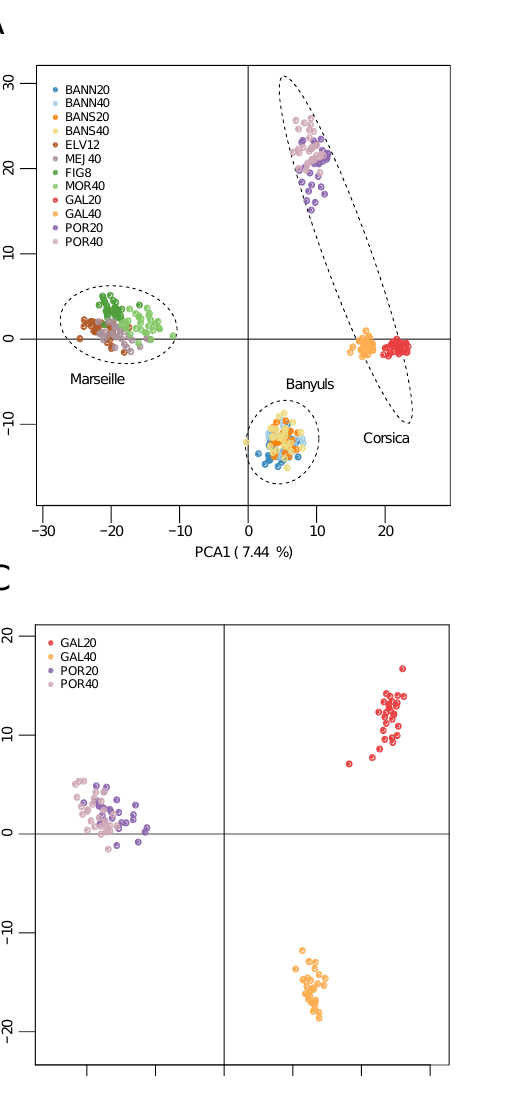
Figure 1. Principal component analysis (Axes 1 and 2) of A) the 12 red coral populations (n = 354 individuals, 27 461 SNPs), B) the four red coral populations from Marseille (n =119 individuals, 27 461 SNPs), C) the four red coral populations from Corsica (n =117 individuals, 27 461 SNPs), D) the four red coral populations from Banyuls (n =118 individuals, 27 461